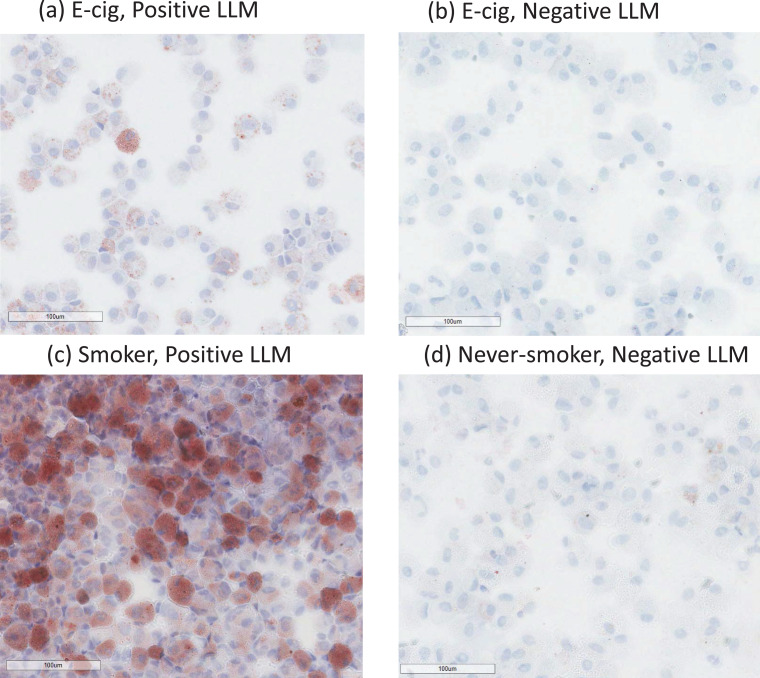
Examples of bronchoalveolar lavage fluid Oil-Red-O stains for LLM showing the presence of macrophages with prominent cytoplasmic lipid accumulation in positive samples. (a) E-cigarette user and (c) smoker; and negative samples with macrophages lacking cytoplasmic lipid: (b) E-cig user and (d) never-smoker. Original magnification x400.